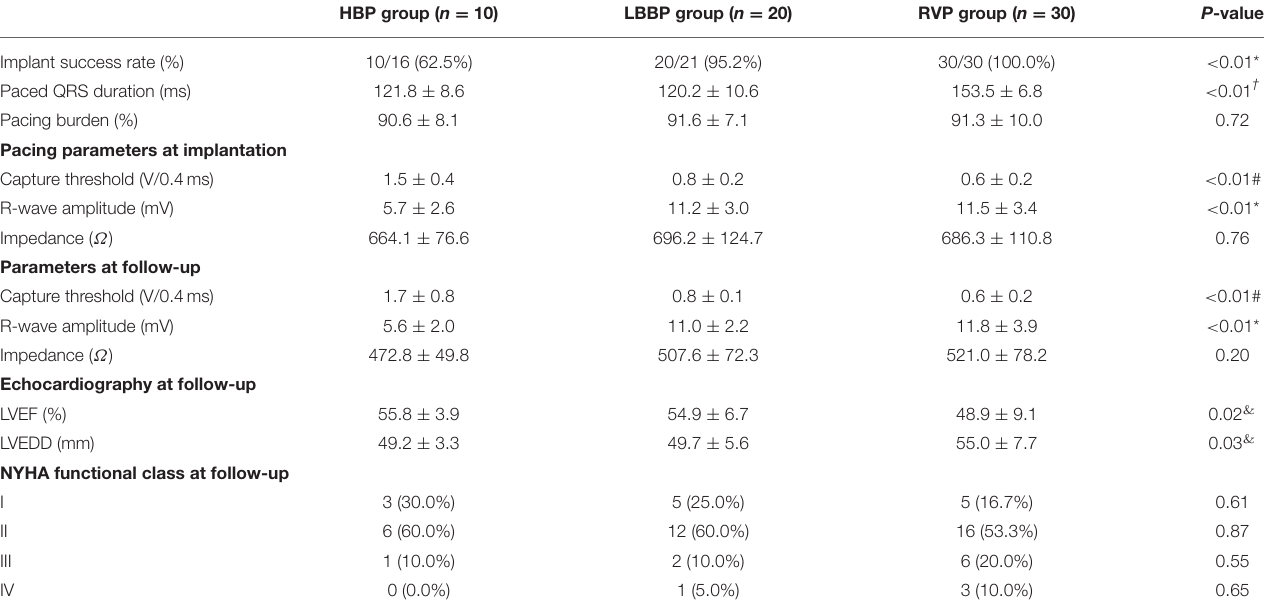
TABLE 3 | Procedural and clinical outcomes among